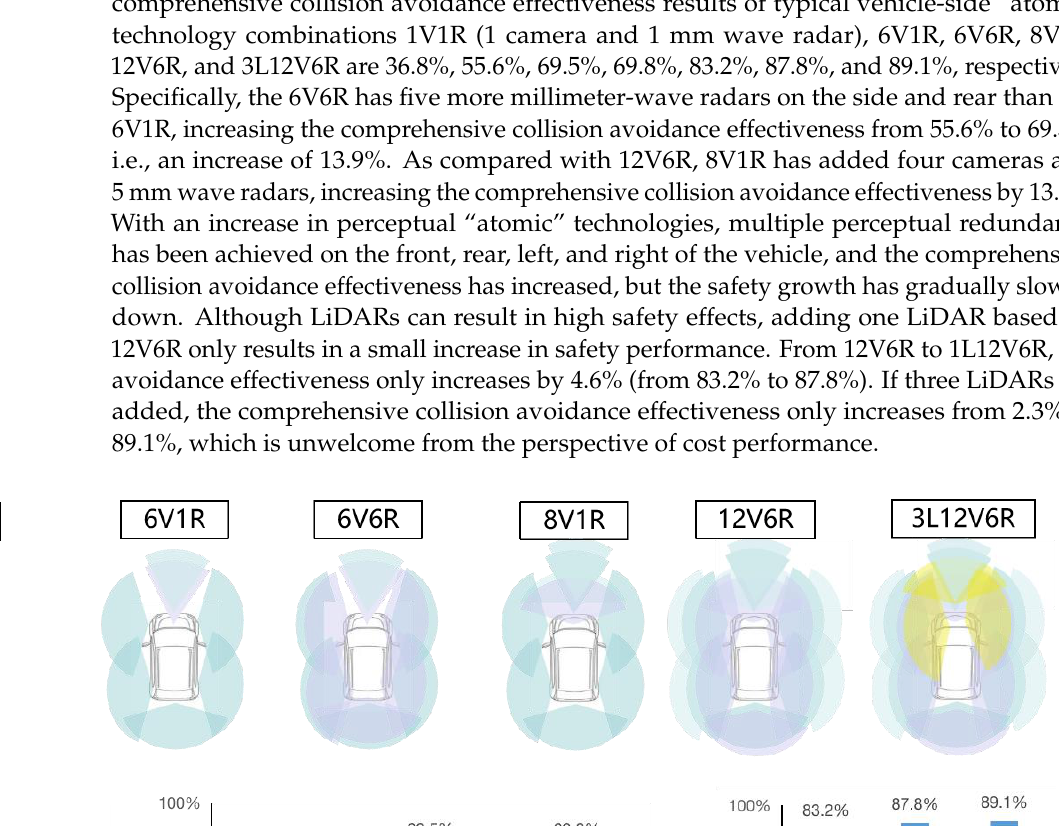
Figure 3. Comprehensive collision avoidance effectiveness and cost of different “atomic” technolo- gies.